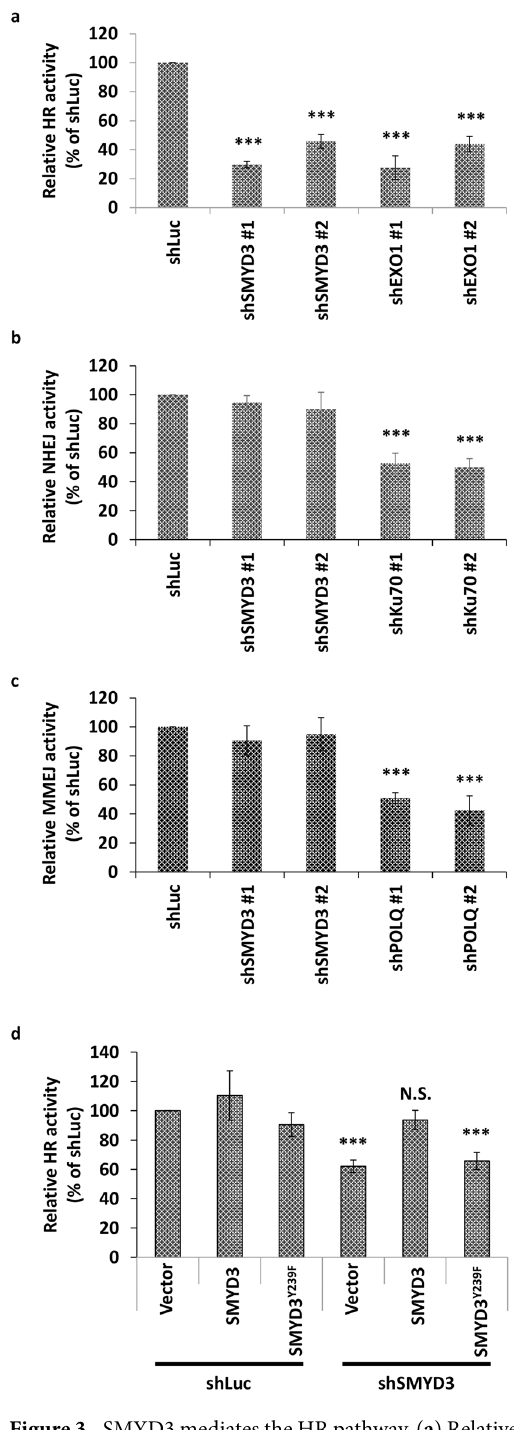
Figure 3. SMYD3 mediates the HR pathway. ( a ) Relative HR activity of shLuc, shSMYD3, and shEXO1 MCF7 cells, which was indicated by the percentage of GFP-positive cells relative to the shLuc control. The EXO1 knockdown cells were used as a positive control. *** P < 0.001 vs. shLuc control. ( b ) Relative NHEJ activity of shLuc, shSMYD3 and shKu70 cells. NHEJ activity was measured by normalizing the luciferase activity to the renilla activity. The Ku70-knockdown cells were used as a positive control. *** P < 0.001 vs. shLuc control. ( c ) Relative MMEJ activity of shLuc, shSMYD3 and shPOLQ MCF7 cells, which was indicated by the percentage of GFP-positive cells relative to the shLuc control. The POLQ-knockdown cells were used as a positive control. *** P < 0.001 vs. shLuc control. ( d ) Exogenous expression of SMYD3, but not the mutant SMYD3 Y239F , restored the HR activity. *** P < 0.01 vs. shLuc with the expression of the vector plasmid control. N.S.: not